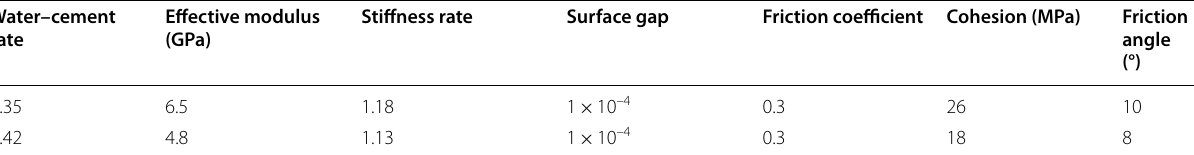
Table 4 Input factors for the cement paste.